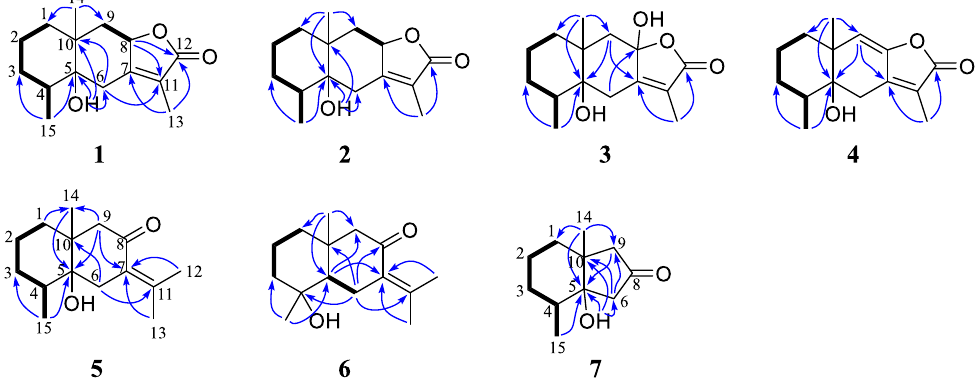
Figure 2. 1 H- 1 H COSY ( ━ ) and selected HMBC correlations (H → C) of compounds 1 – 7 . The relative configuration of 1 was established by the NOESY spectrum. The cross peaks of H-8/H 3 -14, H 3 -14/H-6 β , H-6 β /H-4, and H 3 -14/H-4 (Figure 3) demonstrated that these protons were oriented on the same sides and arbitrarily assigned as β -orientation,